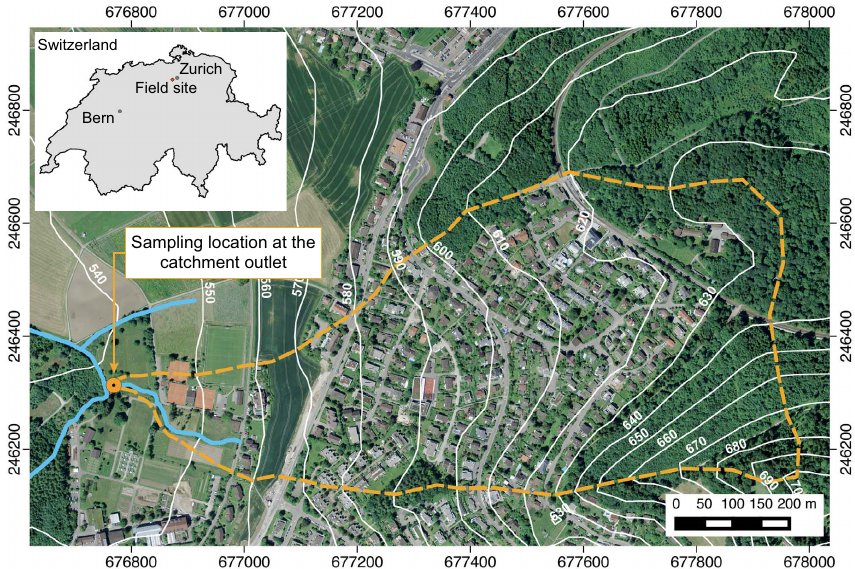
Figure 4. Location of the field site at a small creek on the property of the Swiss Federal Institute for Forest, Snow and Landscape Research (WSL) near Zurich, Switzerland. The catchment boundaries are